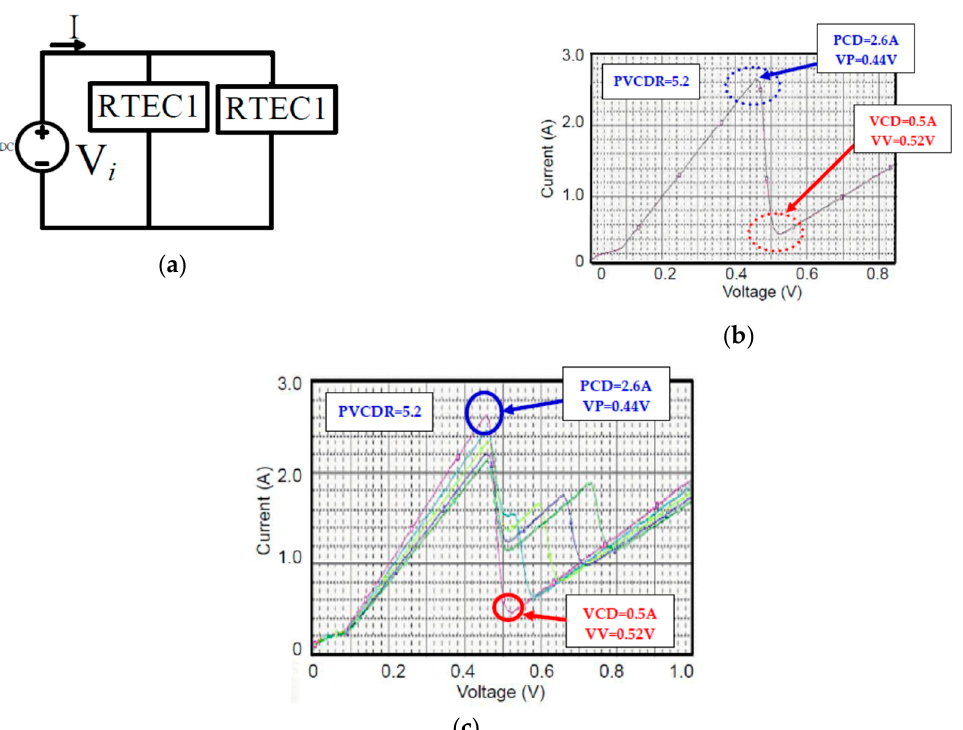
Figure 5. ( a ) Paralleled structure of two PVCDR RTEC units. ( b ) Single NDR curve of paralleled structure of two PVCDR RTEC units with PCD value of 2.6 A. ( c ) Double NDR curve of double PVCDR RTEC structure with variable R S .